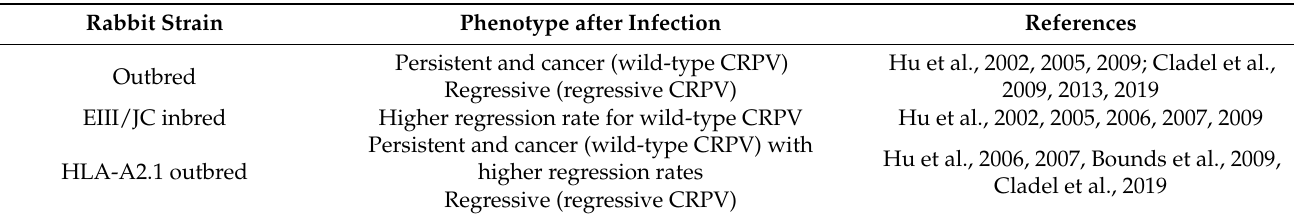
Table 3. Rabbit strains used in our